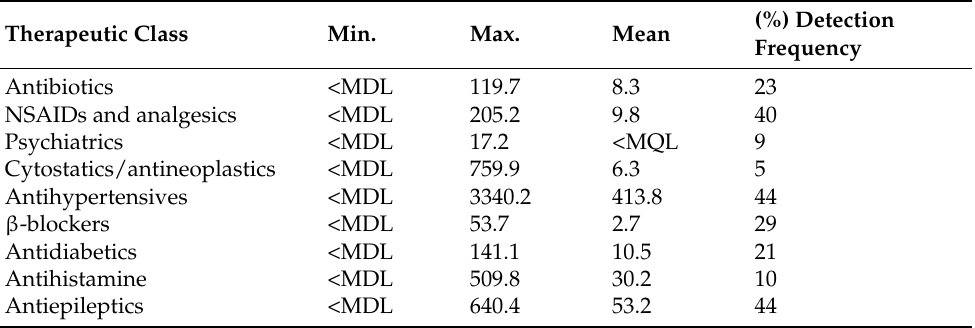
Table 1. Occurrence values (ng/L) for the therapeutic classes of PhACs detected in the effluents of the studied WWTP. Concentrations (ng/L) are calculated as the minimum, maximum, and average from all sampling